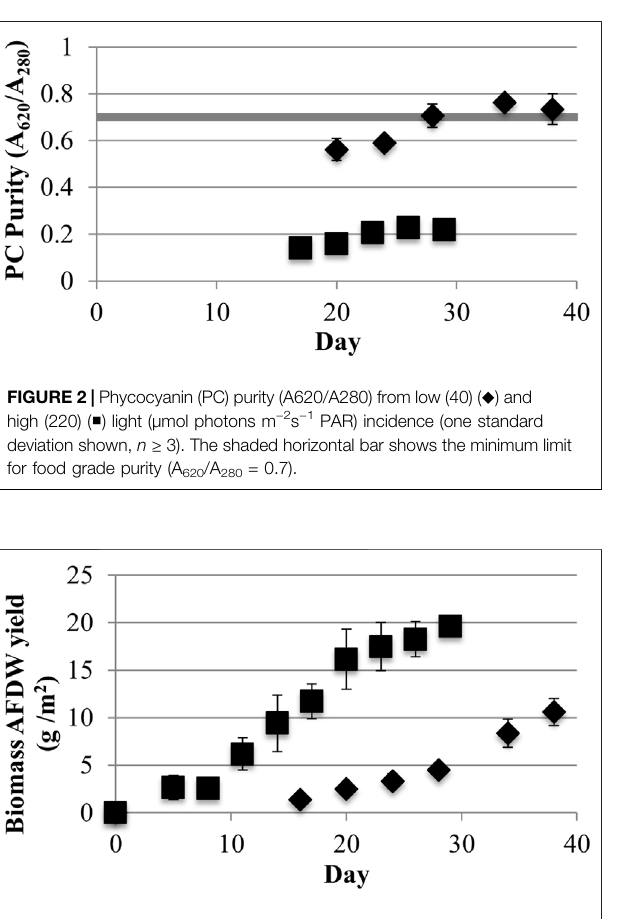
FIGURE 3 | Growth surface area biomass Ash Free Dry Weight (AFDW) yields from low (40) ( ◆ ) and high (220) ( ■ ) light ( μ mol photons m − 2 s − 1 PAR) conditions (one standard deviation shown, n ≥ 3).